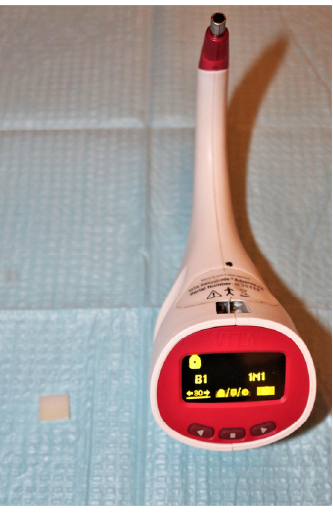
Figure 1. Spectrophotometer used in this study and with Vita Classical and 3D Master shades reading.